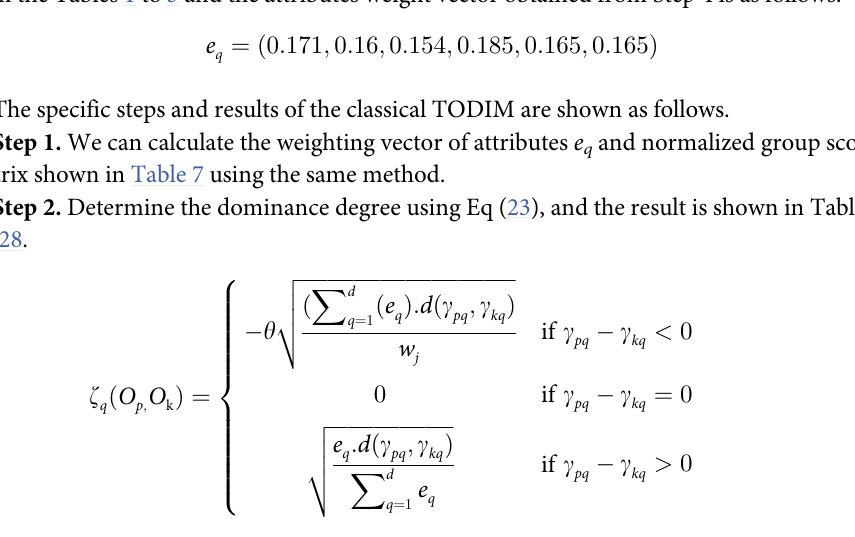
from the Tables 1 to 3 and the attributes weight vector obtained from Step 4 is as follows: